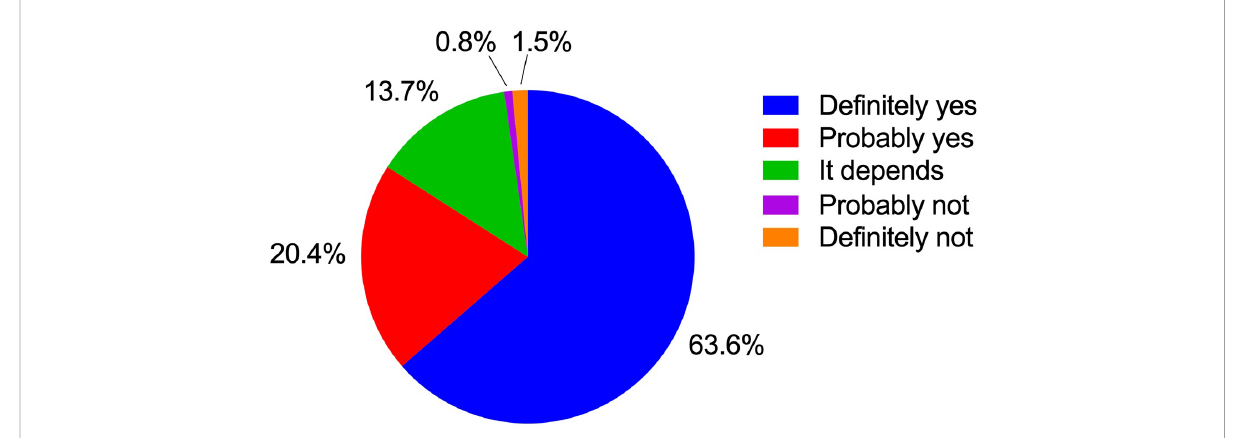
FIGURE 5 Reponses (%) towards ban of animal ownership when offenders are found guilty of animal cruelty (n=2152). “ If someone was found guilty of animal cruelty, do you believe they should be banned from owning animals? ”